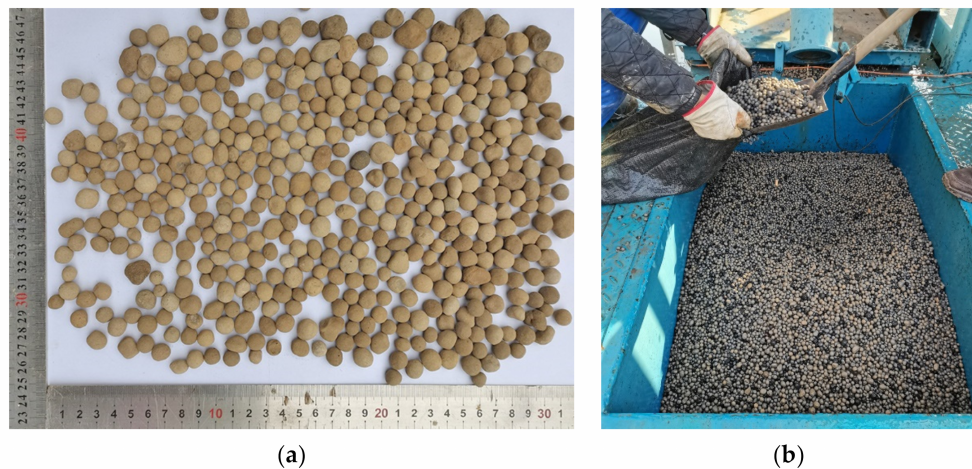
Figure 9. ( a ) Clay-fired simulated nodule particles; ( b ) calibrated nodules for sampling in